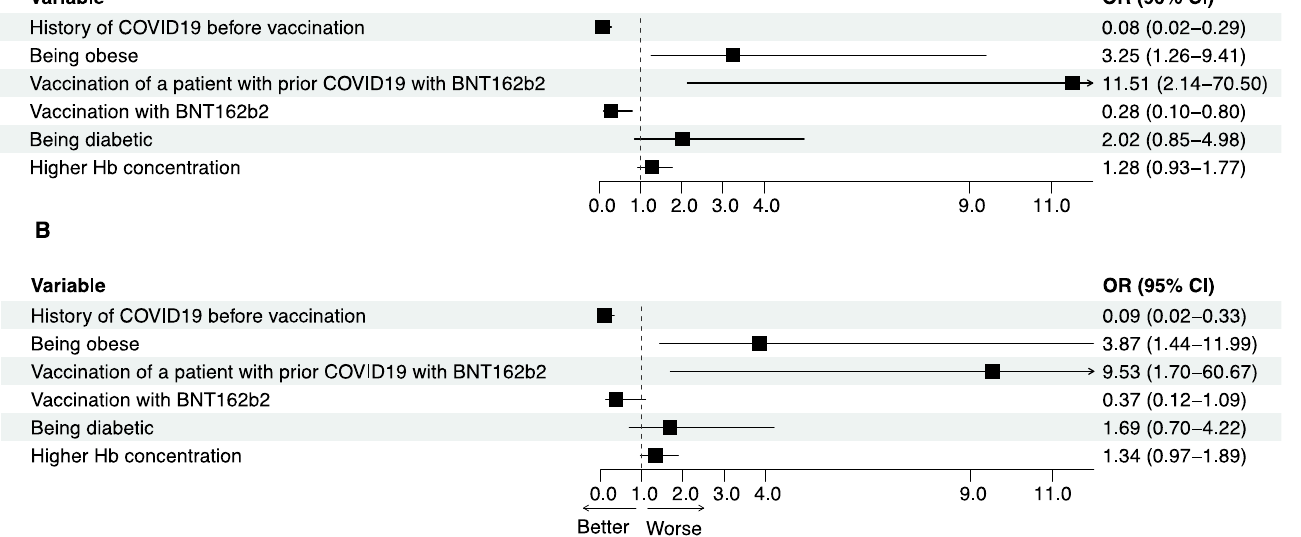
Figure 4. ( A ) Results of the adjusted multivariable analysis of predictive factors of anti-S IgG waning. ( B ) Sensitivity analysis. Results of the adjusted multivariable analysis of predictive factors of anti-S IgG waning after removal of patients who contracted COVID-19 during the study duration. (OR odds ratio, CI confidence interval, black square—odds ratio, black line—95% confidence interval).